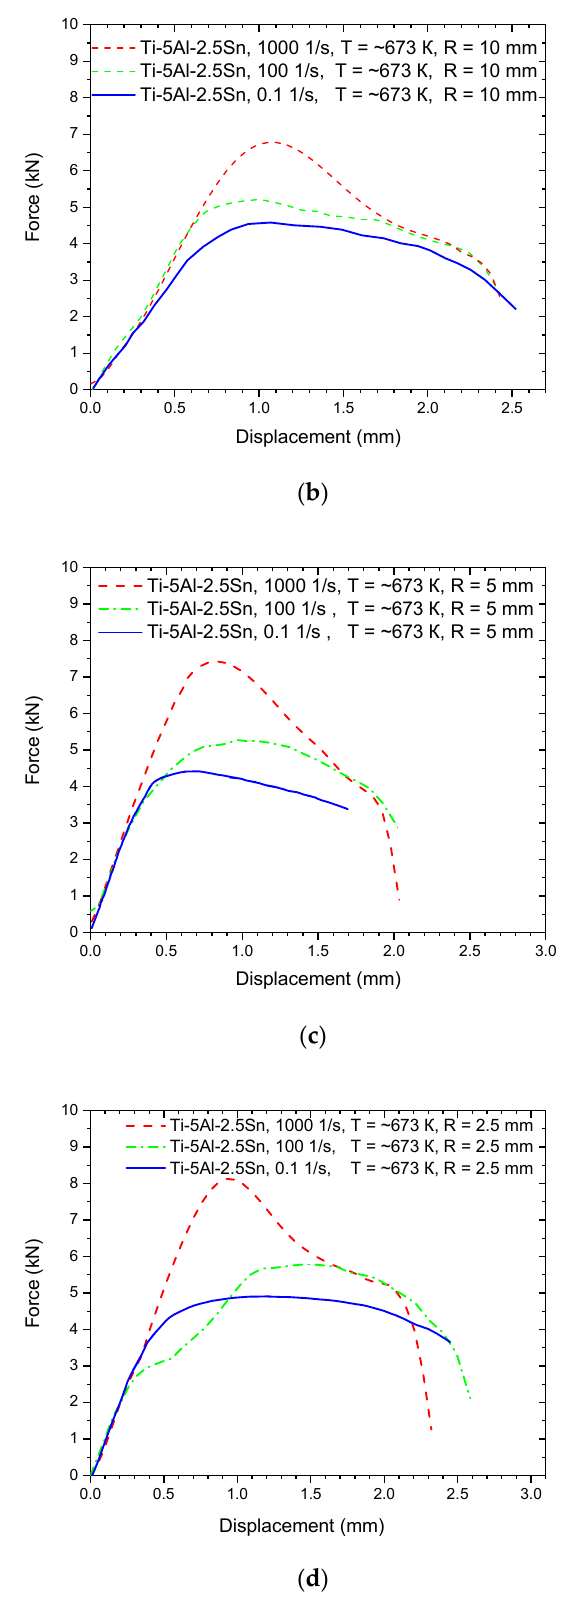
Figure 3. Force versus displacement of Ti-5Al-2.5Sn specimens under tension at strain rates of 0.1, 100, and 1000 s − 1 ; ( a ) specimens without notch; ( b ) specimens with notch radius R = 10 mm; ( c ) R = 5 mm; and ( d ) R = 2.5